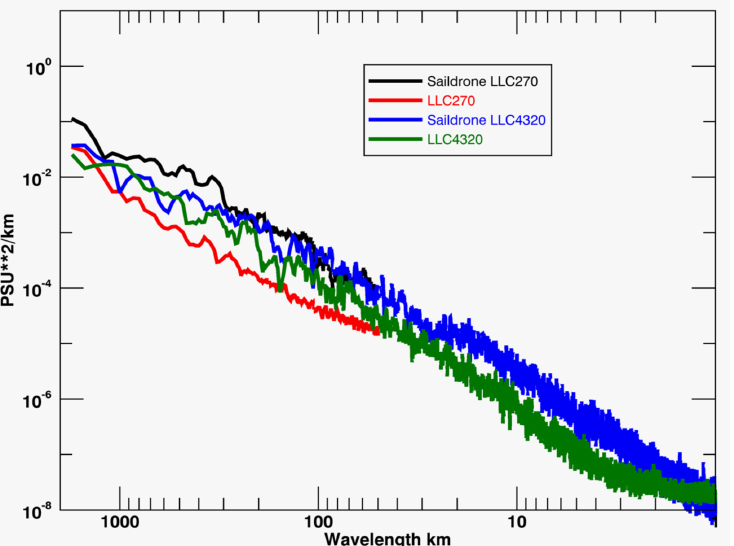
Figure 6. Wavenumber spectra for LLC270 and LLC4320. Differences between the SMAP/Saildrone spectra and the model/Saildrone comparisons can be explained by the different model